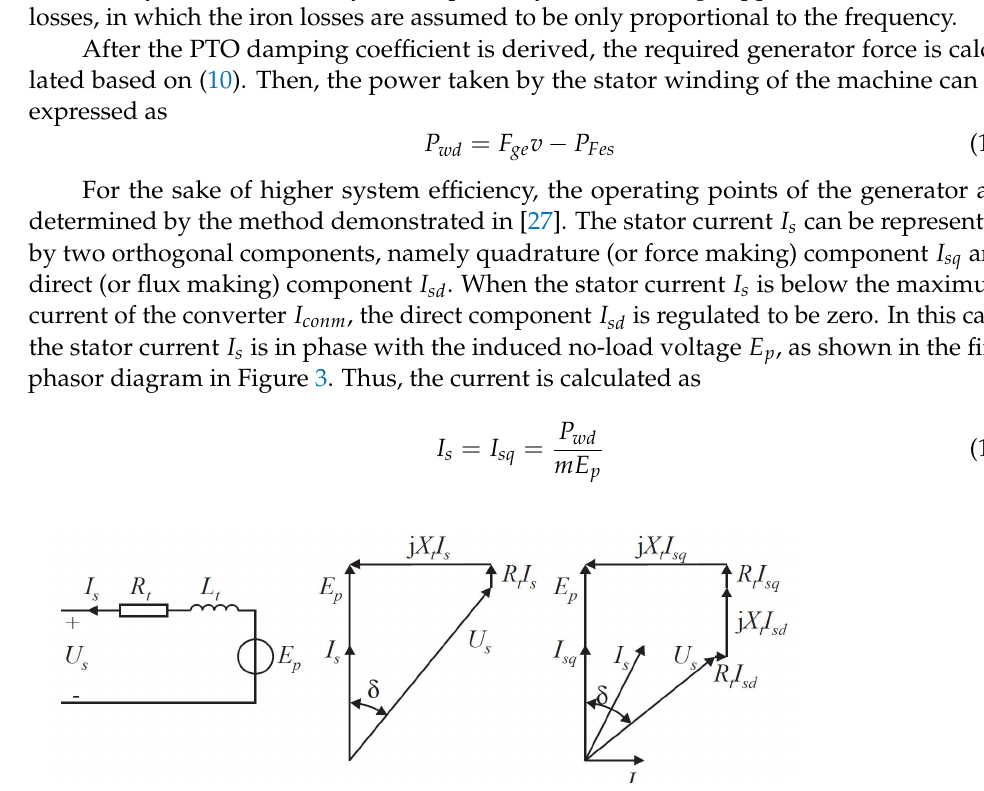
Figure 3. Equivalent circuit and the phasor diagram of the linear